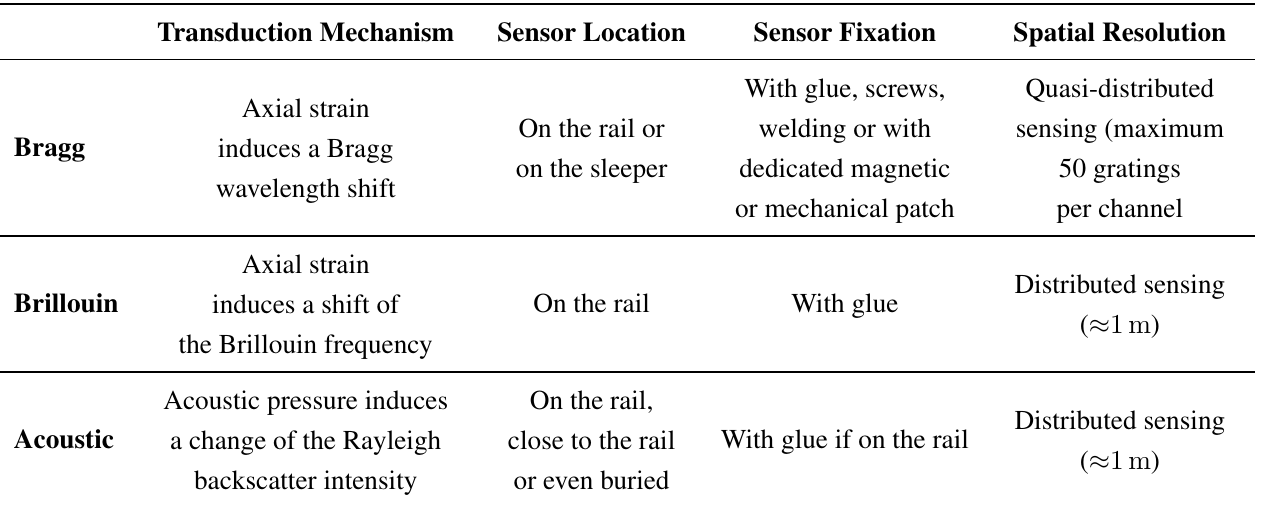
Table 2. Performances of optical fibre transducers for railway